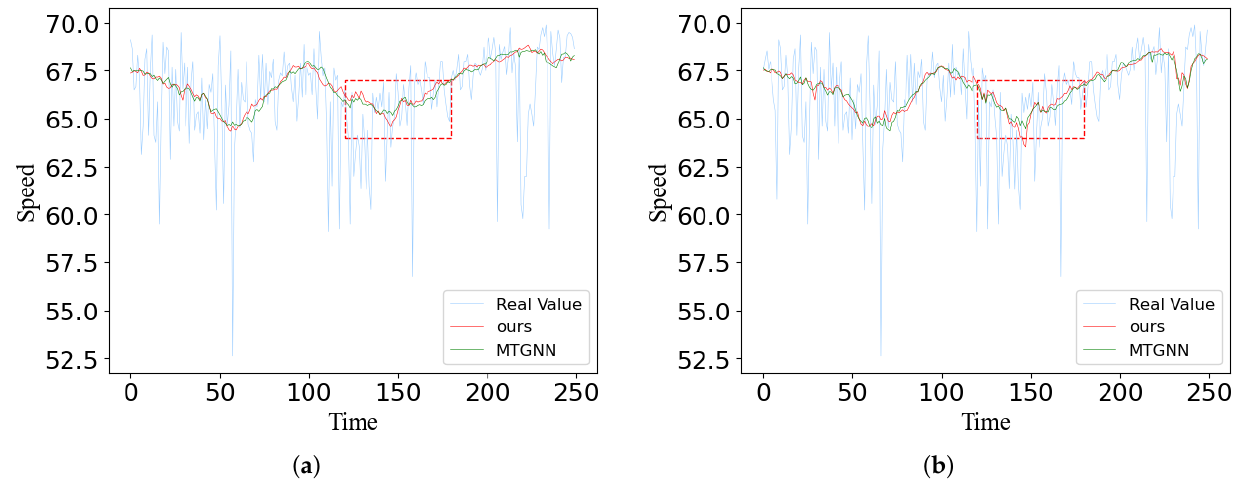
Figure 13. Traffic speed case study of two different stations on the PEMS-BAY dataset: ( a ) sensor 1; ( b ) sensor